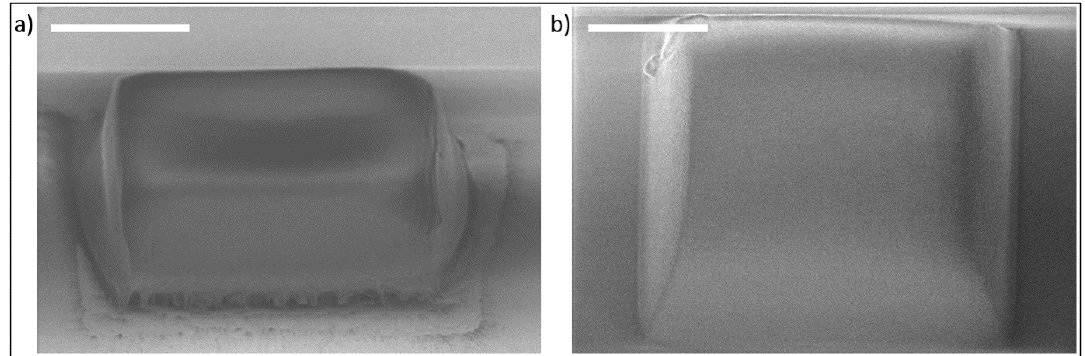
Figure 6. Blocks from solvent free R3; ( a ) on reflective surfaces (block measured at 9.33 µm × 22.8 µm) and ( b ) on transparent surfaces (block measured at 12.5 µm × 32.3 µm at the surface to 22.9 µm at the shrunk side). The laser scribe field is 30 µm × 30 µm × 10 µm. Scale bars are 10 µm.